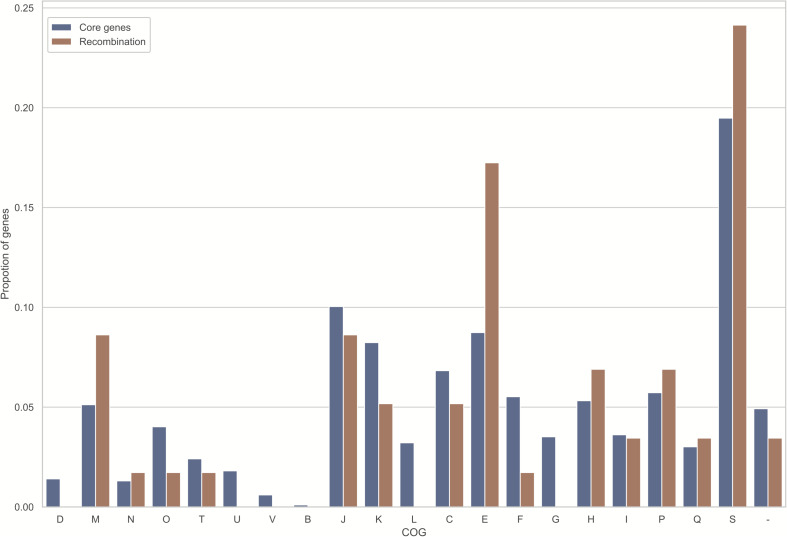
Those homologously recombined genes are distributed across every COG evenly. The X-coordinates stand for the diverse functional categories of COG, while the Y-coordinates stand for gene proportion within every functional category. Meanwhile, the blue and orange bars represent proportion of single copy genes of each COG, and that of recombined genes (FDR < 10%), separately. Meanwhile, those COG categories are shown below: D, chromosome partitioning, cell division, cell cycle control; M, cell envelope/membrane/wall biogenesis; N, cell motility; O, modification at post-transcription level, chaperones and protein turnover; T, mechanisms of signal transduction; U, vesicular transport, secretion and intracellular trafficking; V, mechanisms of defense; B, chromatin dynamics and structure; J, translation, such as biogenesis and ribosomal structure; K, transcription; L, repair, recombination and replication; C, energy conversion and production; E, amino acid transport and metabolism; F, nucleotide transport and metabolism; G, carbohydrate metabolism and transport; H, coenzyme metabolism and transport; I, lipid metabolism and transport; P, inorganic ion metabolism and transport; Q, catabolism, transport, and biosynthesis of secondary metabolites; S, unknown function; –, unknown proteins not collected in COG categories.